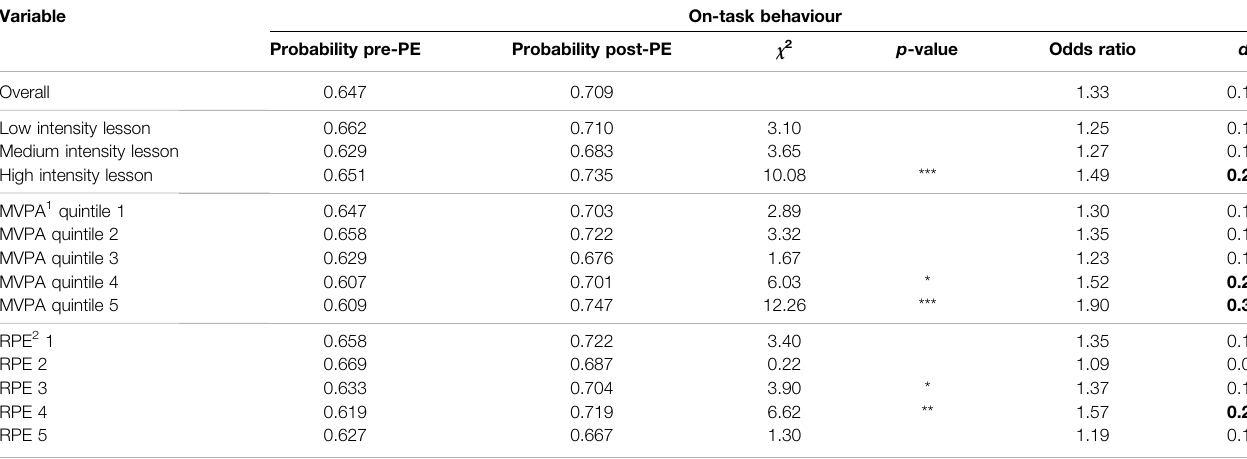
TABLE 2 | Response of on-task behaviour to objective and subjective PA.